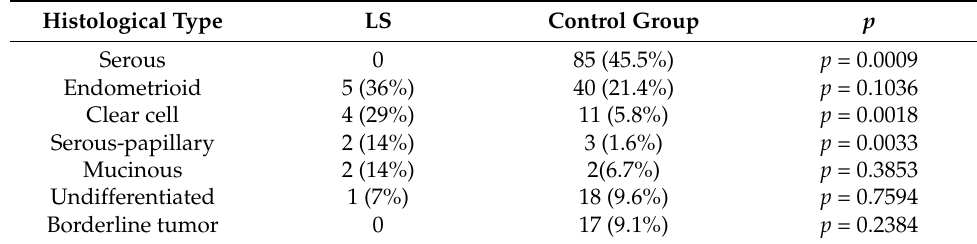
Table 7. Histological type of OC in the LS group and in the control